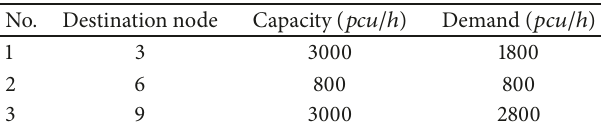
Table 13: Detailed information for shelter choice in Case 2 when 𝜇 = 2.00 . No. Destination node